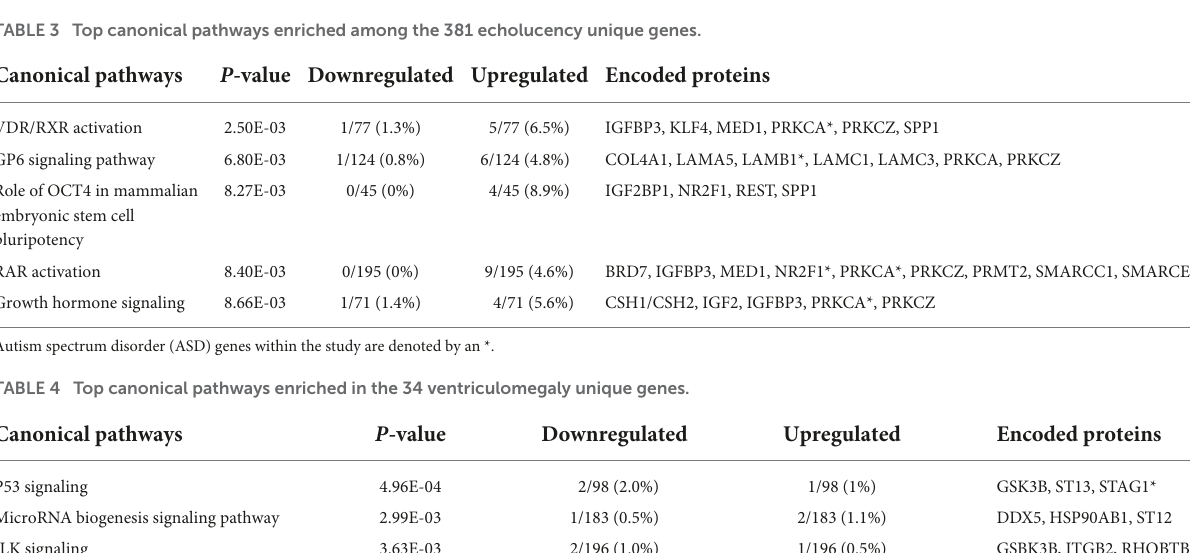
TABLE 3 Top canonical pathways enriched among the 381 echolucency unique genes.